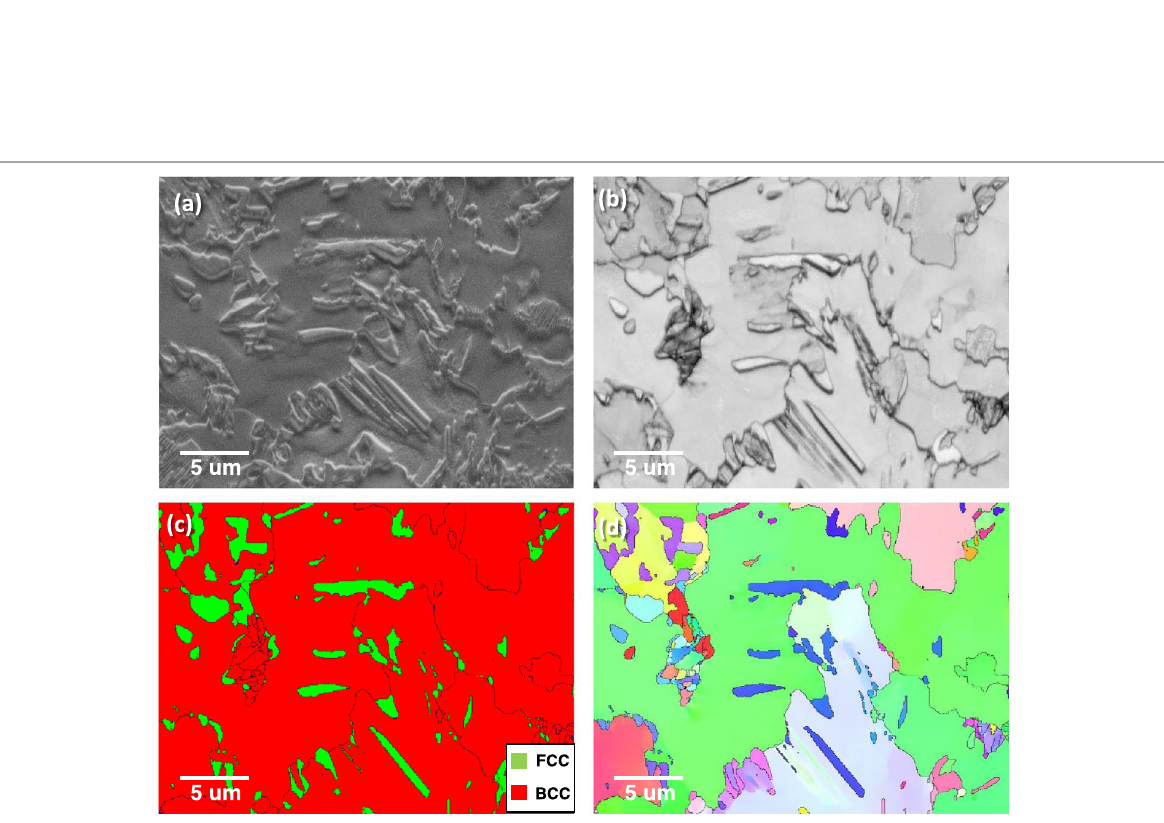
Fig. 7 The morphology of retained γ (FCC) in high magnification; a secondary electron image, b band contrast, c phase, and d inverse pole figure